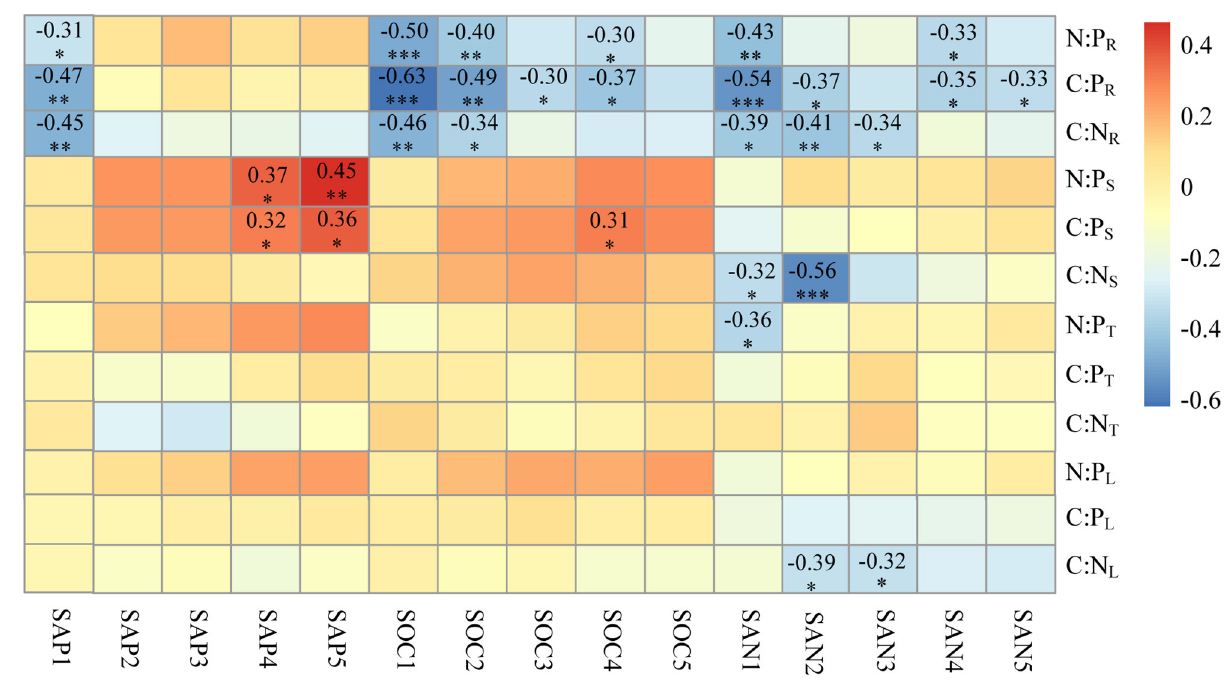
FIGURE 6 | Pearson correlations of the C:N, C:P, and N:P ratios of Alhagi sparsifolia with soil nutrients across the 1-m deep soil profile. The numbers shown are the significant correlation coefficients. Statistical significance is denoted by asterisks: ***: p < 0.001; **: p < 0.01; *: p < 0.05; ns, not significant. The C:N ratios in leaf, thorn, stem, and root organs are abbreviated as C:N L , C:N T , C:N S , and C:N R , respectively; likewise for C:P as C:P L , C:P T , C:P S , and for C:P R ; for N:P as N:P L , N:P T , N:P S , and N:P R . SAN1–5 is soil alkali hydrolysable nitrogen at 0–20, 20–40, 40–60, 60–80, 80–100cm depths; similarly, for SOC1–5, soil organic carbon; SAP1–5, soil available